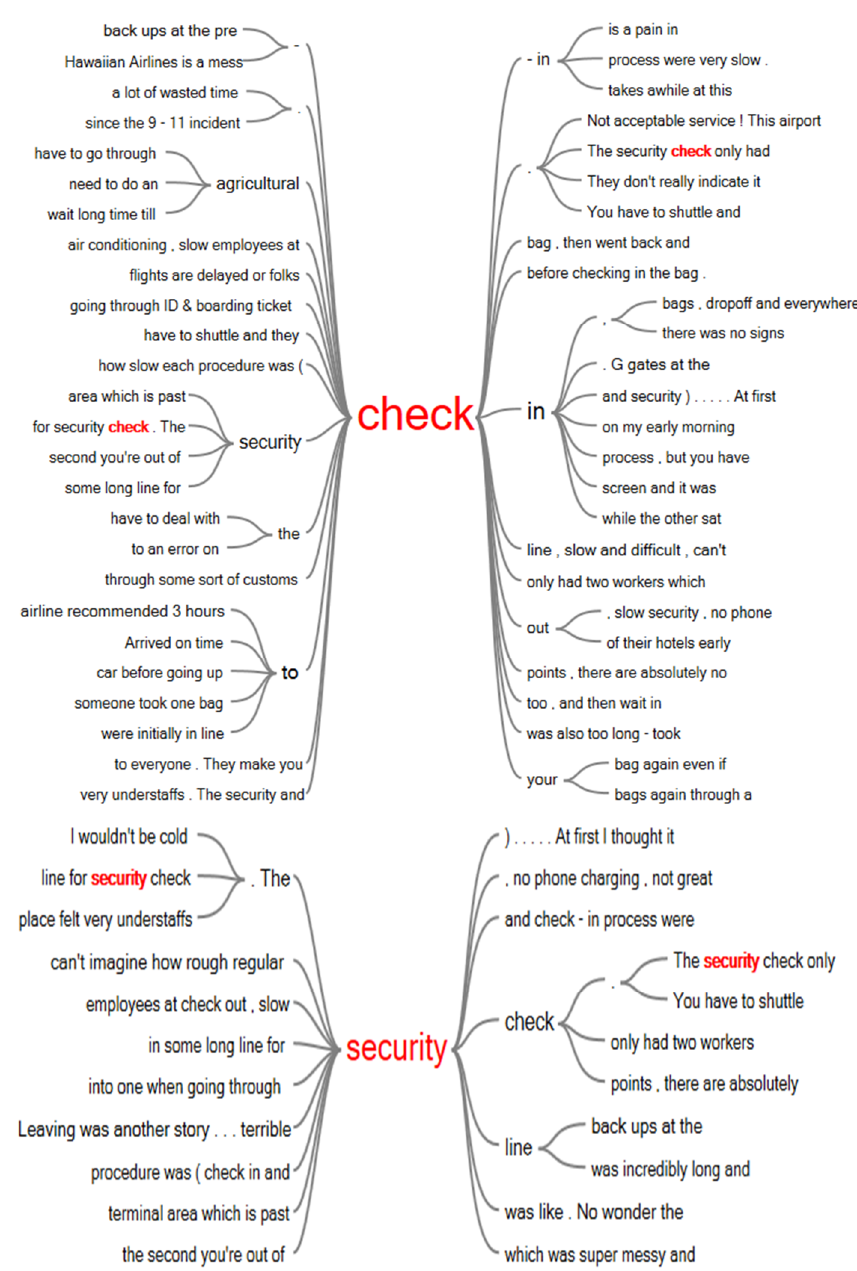
Figure A2. Word Trees “Check” and “Security” for the Dissatisfied Travelers at HIA.